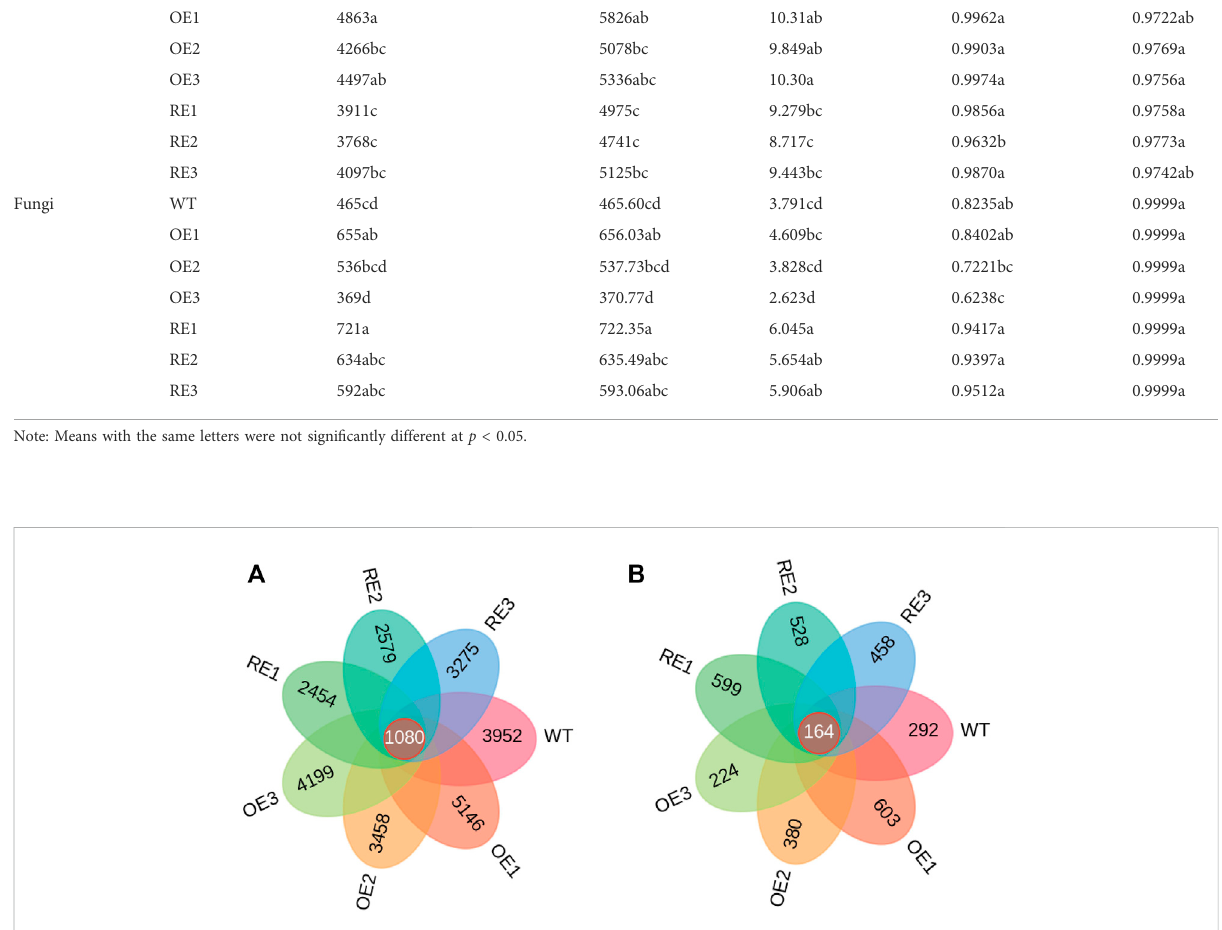
FIGURE 3 ASV Wayne diagram of bacteria and fungi in rhizosphere soil of P. alba × P. berlinensis. (A) Bacteria (B)